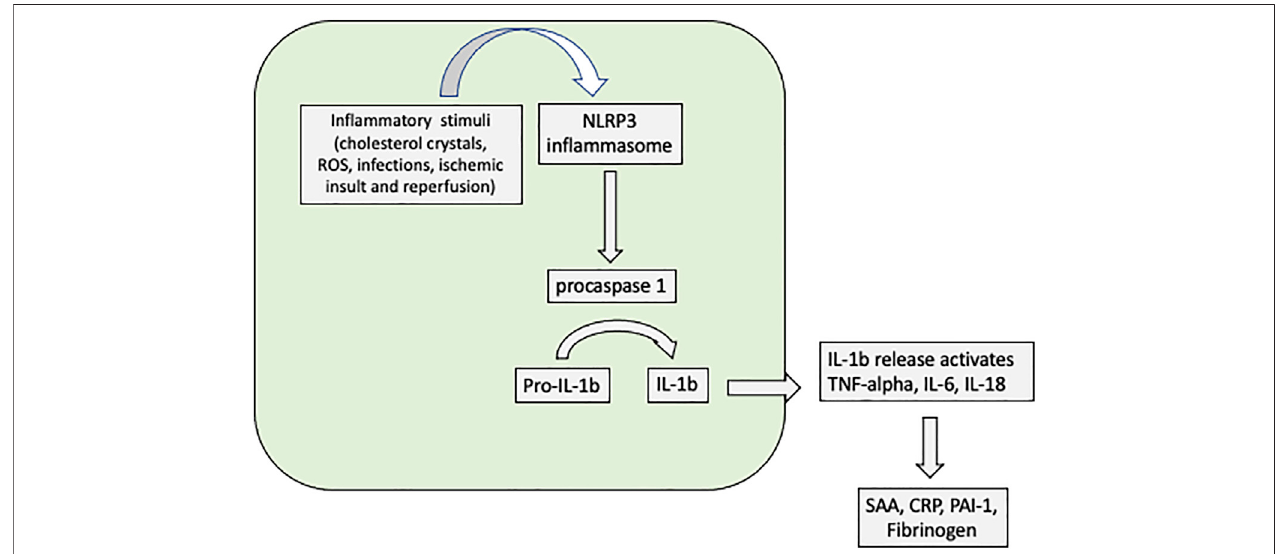
FIGURE 2 | NLRP3 activation triggers the in fl ammatory pathway of atherosclerosis in monocytes and macrophages resident cells. The ischemic insult due to ischemiaandreperfusionafteracutemyocadialinfarctionactivatesthein fl ammatorypathwaymediatedbyNLRP3.ROS — reactiveoxygenspecies;NLRP3-nucleotide- binding and oligomerization-like receptor pyrin domain-containing protein 3; IL — interleukin; SAA — serum amyloid A; CRP — C-reactive protein; TNF-alpha — tumour necrosis factor — alpha; PAI-1 — plasminogen activator inhibitor type 1. NLRP3 in fl ammasome is a common in fl ammatory platform where many stimuli (e.g., cholesterol crystals, ischemic conditions) can activate IL-1beta triggering the in fl ammatory pathway, including IL-6. The activation of IL-1beta reduces contractility in response to beta adrenergic stimuli and is associated with ventricular remodeling. Further, increase in CRP levels can be used for monitoring of the low-grade in fl